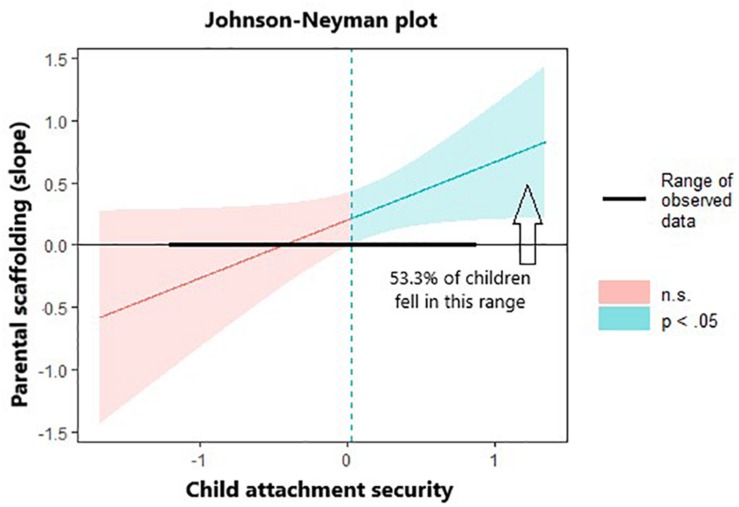
Johnson-Neyman plot.